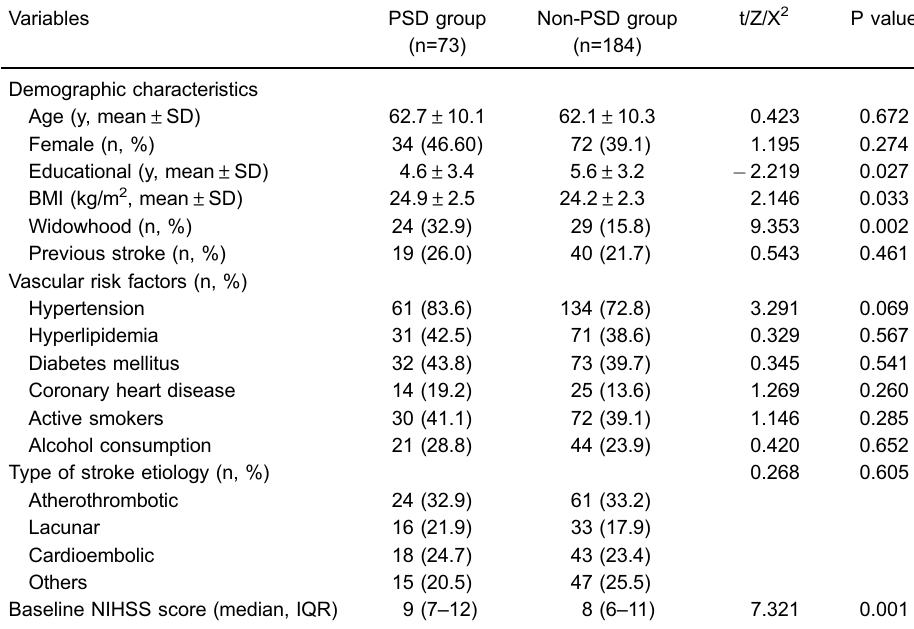
Table 2. Baseline clinical characteristics of patients with and without post-stroke depression (PSD) at 1